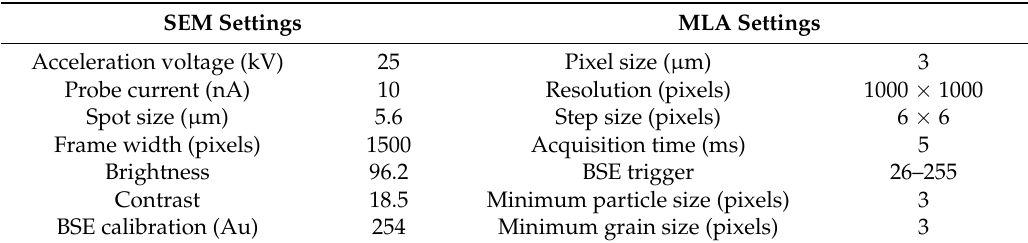
Table 2. SEM-MLA data acquisition